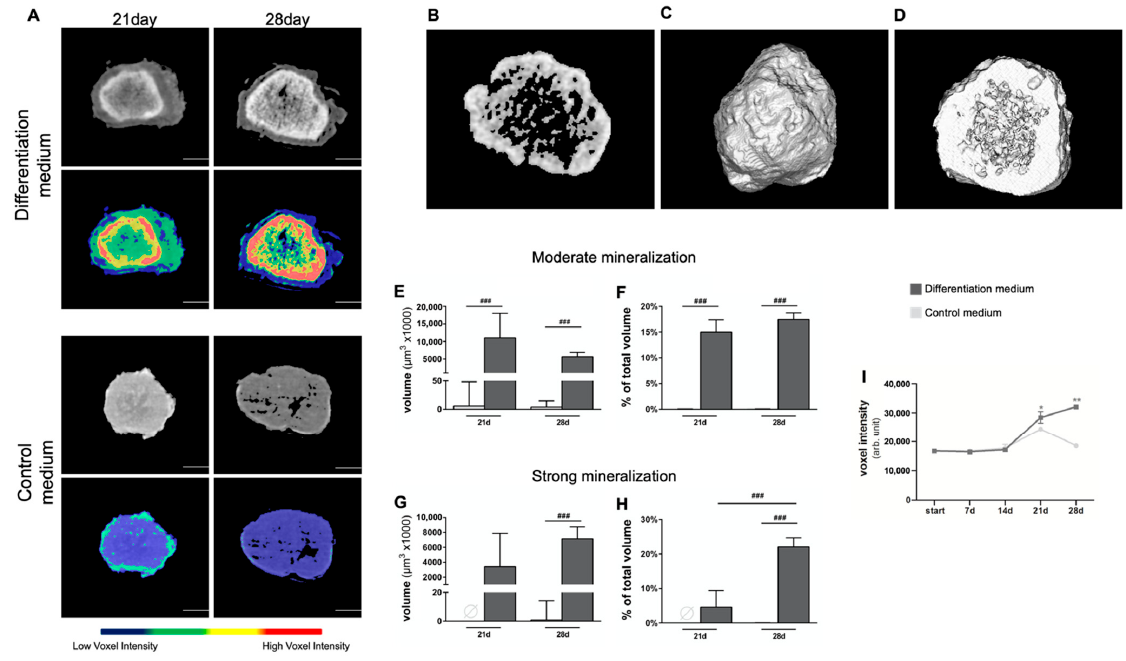
Figure 4. Volumetric quantification of biomineralization in spheroids by micro-CT. ( A ) On top, original micro-CT image; below, pseudo-colored image after segmentation by voxel intensity. Rep- resentative 2D ( B ) and 3D ( C ) reconstruction with corresponding cross-section ( D ) showing the min- eralized core of a spheroid cultured for 28 d under osteogenic conditions. Note the central trabecu- lar-like mineralization pattern surrounded by a ring-shaped mineralization. ( E – H ) Micro-CT-based volumetric quantification of biomineralization, with arbitrarily chosen pixel intensity cut-off values, discriminating moderate (E, F) and strong mineralization ( G , H ) by objective differences in the cen- tral calcium deposit volume. Significant differences were evaluated using a one-way ANOVA ( n = 6, mineralizing groups; n = 5 control groups), followed by Tukey’s post hoc test. ( I ) Changes in mean voxel intensities over time. Statistical differences were calculated by Kruskal–Wallis method fol- lowed by Dunn’s post hoc test. ### p < 0.001 as indicated; * p < 0.05, ** p < 0.001 vs. starting day. Data represent geometric mean ± 95% CI. 3.1.3. Formation of Native Hydroxyapatite-like Biomineralization in Spheroid Cultures After thorough determination of quantitative differences in the mineralization pat- terns in osteogenic spheroid cultures by aforementioned techniques, we next set out to characterize quality of the mineralization by energy-dispersive X-ray spectroscopy (EDX) and Fourier transform infrared spectroscopy (FTIR). First, critical-point dried spheroids were examined by scanning electron microscopy (SEM) (Figures 5A–F). Of note, after 28 days of culture, the mineralized core region and the fibrous capsule are identifiable in a cross-sectioned spheroid (100× overview images, Figures 5A vs. D). In higher magnifica- tions (2500× g , Figures 5B,E) of mineralized cores upon cultivation in differentiation me- dium, a collagenous network formation is visible. Note the collagen fibers in which MC3T3-E1 cells are embedded (Figure 5B, see legend for details). In contrast, control sphe- roids from non-mineralizing conditions reveal a rather homogeneous cross section in the overview image (Figure 5D) without apparent collagen fibers (Figure 5E). Next, we used EDX for an elemental analysis of the chemical composition of the min- eral deposits (Figures 5C,F). EDX spectra of the mineralized core regions of a spheroid cultured for 28 days in differentiation medium clearly showed an enrichment of calcium (Ca) and phosphate (P) (Figure 5C). In contrast, such an accumulation was absent in con- trol spheroids (Figure